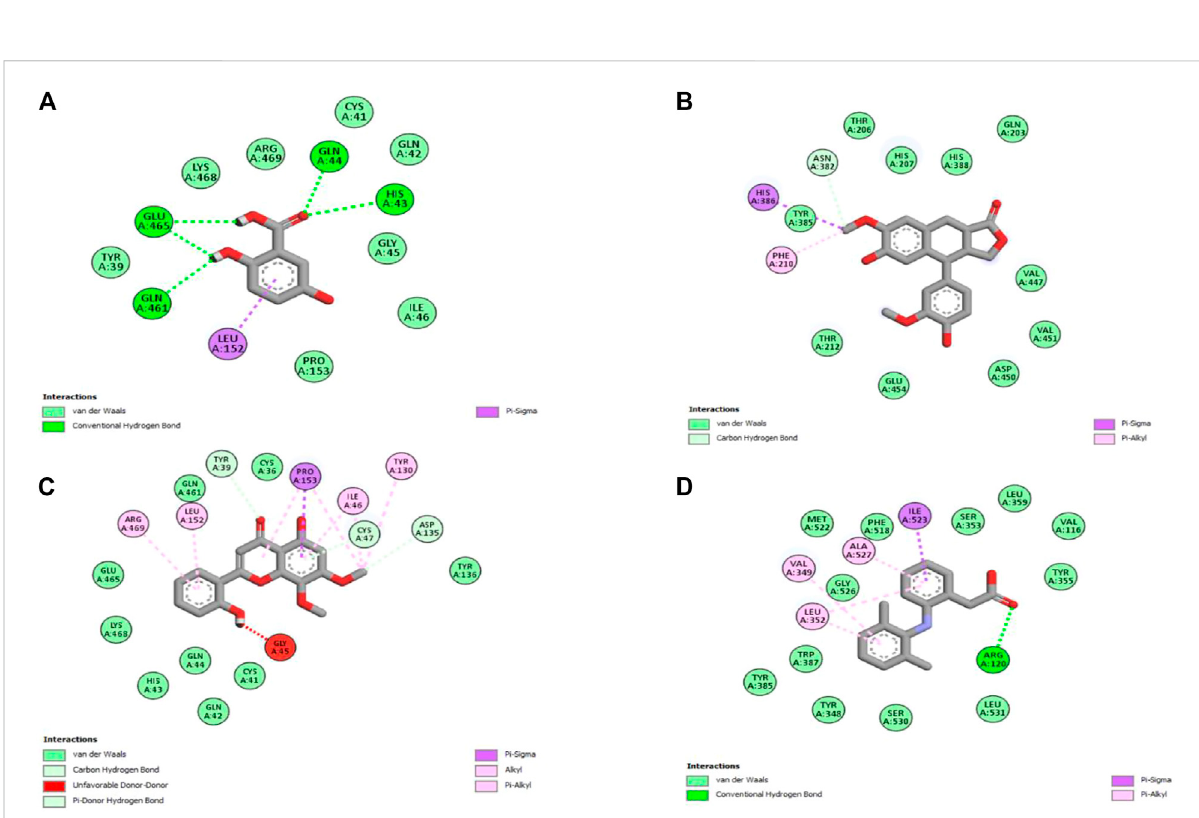
FIGURE 11 Interaction of the major compounds with cyclooxygenase-I. (A) Gentisic acid; (B) conidendrine; (C) skullcap fl avone; and (D) diclofenac.